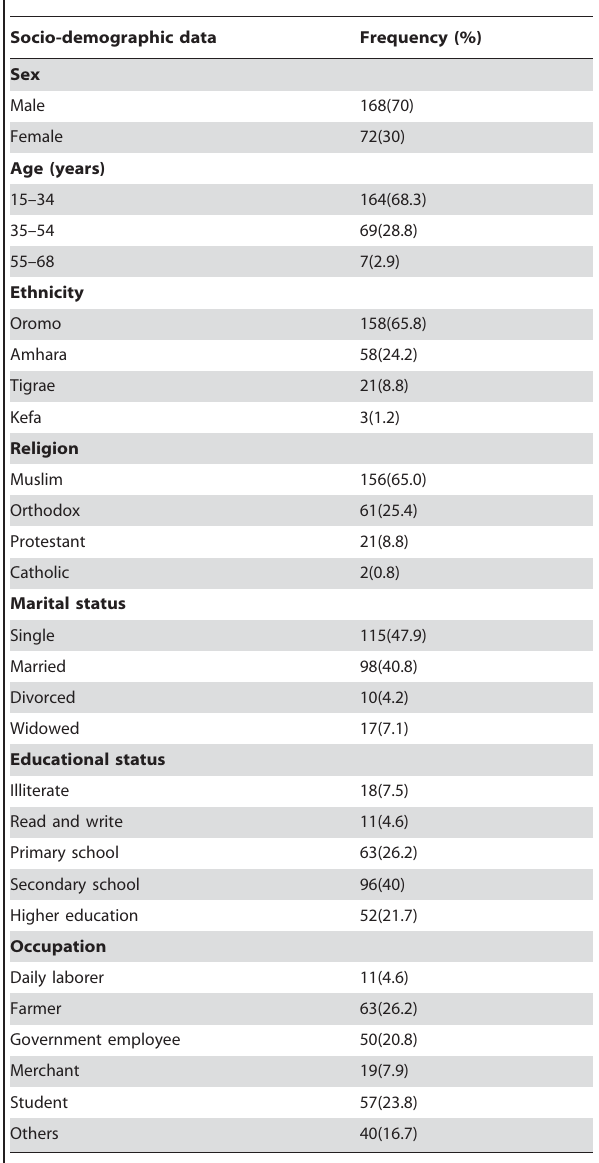
Table 1. Socio-demography of the study participants.